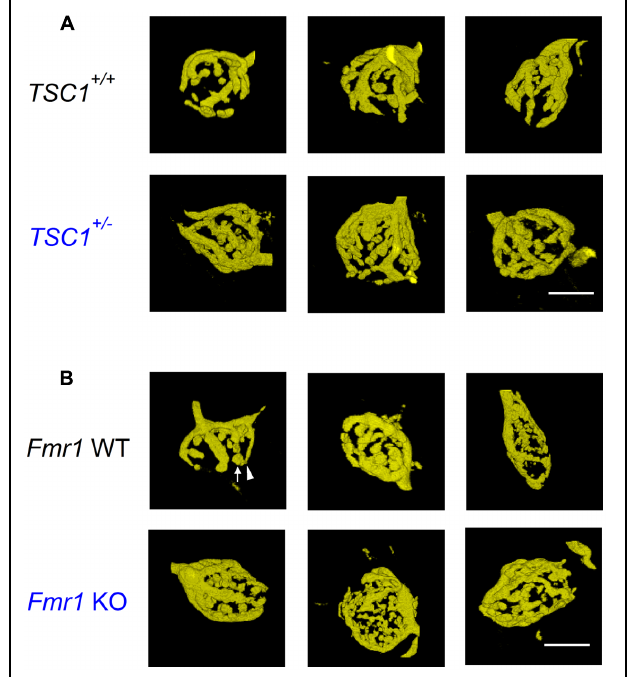
FIGURE 1 | Calyx of Held morphology of Tsc1 + / − and Fmr1 KO mutant mice. (A) Example images of representative, 3D-rendered calyces from wild-type (WT; top row) and Tsc1 + / − (bottom row) mice. (B) Images from WT (top row) and Fmr1 KO mutant mice (bottom row). Arrow indicates bouton; arrowhead neck. Scale bars 10 μ m.